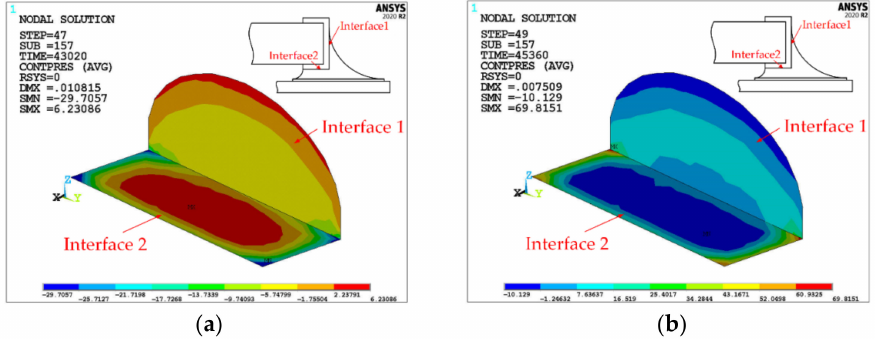
Figure 9. Contact pressure (unit: MPa) distribution at interface 1 and interface 2. ( a ) at 125 ◦ C; ( b ) at − 45 ◦